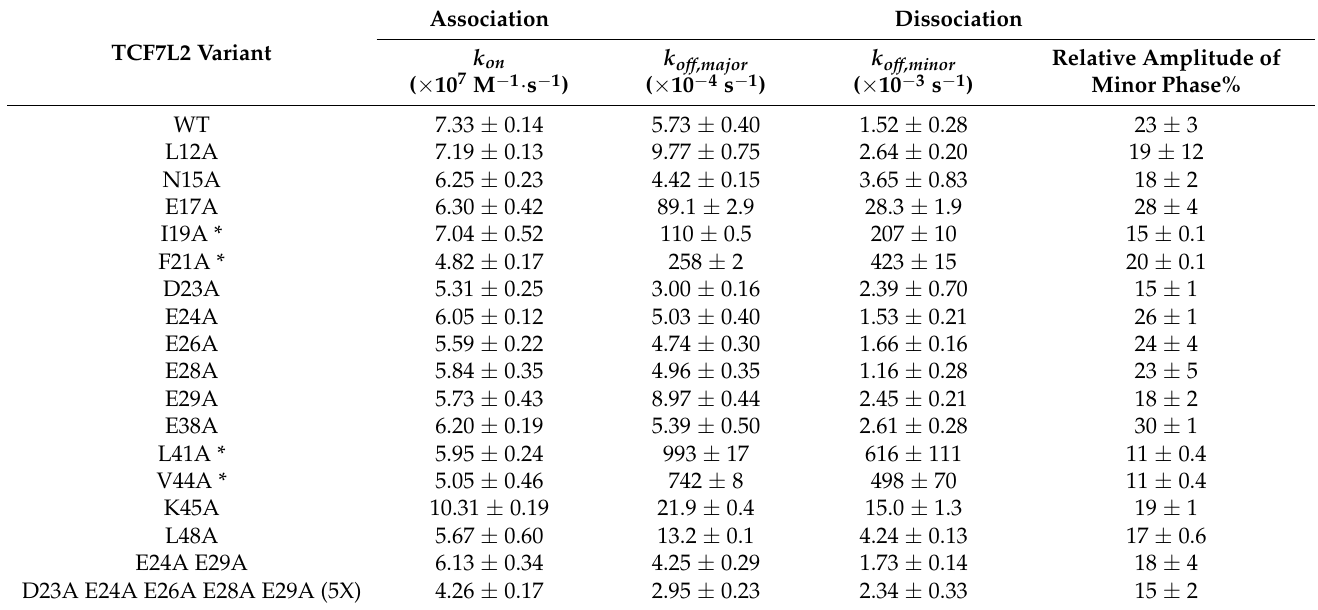
Table 1. Association and dissociation kinetics for the interaction of alanine mutants of TCF7L2 with β -catenin. All mutations were constructed in the S31C variant (denoted as WT) and were labelled with fluorescein at this position. Association kinetics were measured on a stopped-flow fluorimeter, and dissociation kinetics were measured on a fluorimeter. * The exceptions are I19A, F21A, L41A, and V44A, for which the data listed for association and dissociation kinetics were obtained with the stopped flow fluorimeter.